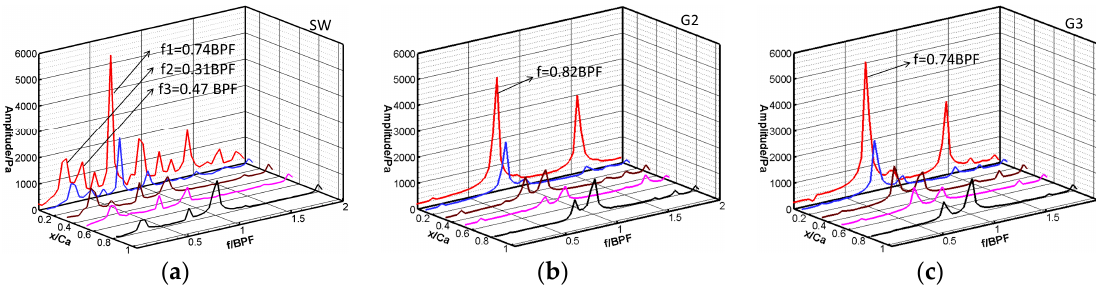
Figure 12. FFT results for numerical probes located near the blade tip along the tip chord in different CTs: ( a ) SW; ( b ) G2; and ( c ) G3.